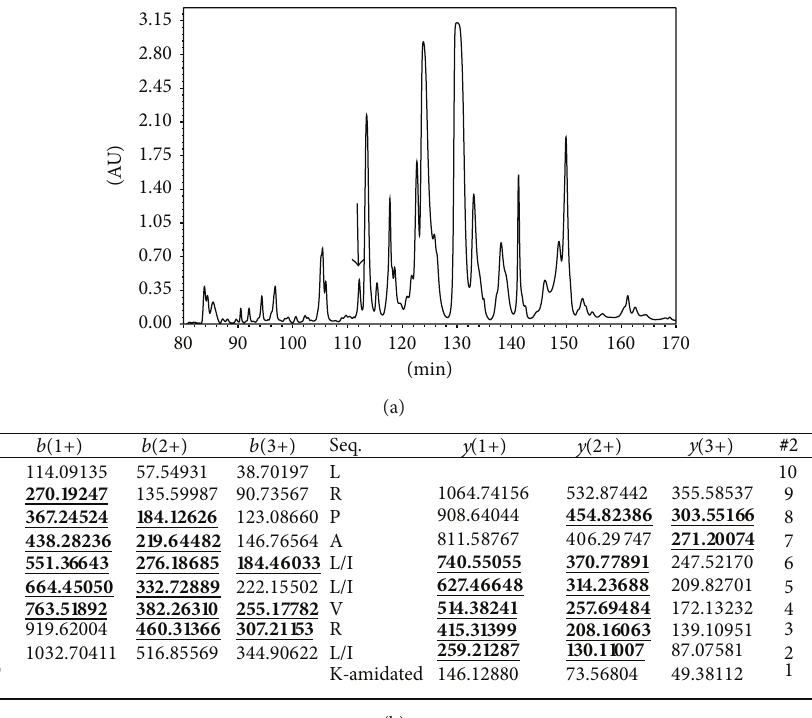
Figure 1: (a) Region of reverse phase HPLC chromatogram of Phyllomedusa baltea skin secretion indicating the absorbance peak corresponding to balteatide (arrow). The 𝑌 -axis represents the relative absorbance at 𝜆 214nm and the 𝑋 -axis represents the retention time in minutes. (b) Predicted 𝑏 - and 𝑦 -ion series (singly, doubly, and triply charged) of balteatide. Ions observed in MS/MS spectra are indicated in bold typeface and are underlined.